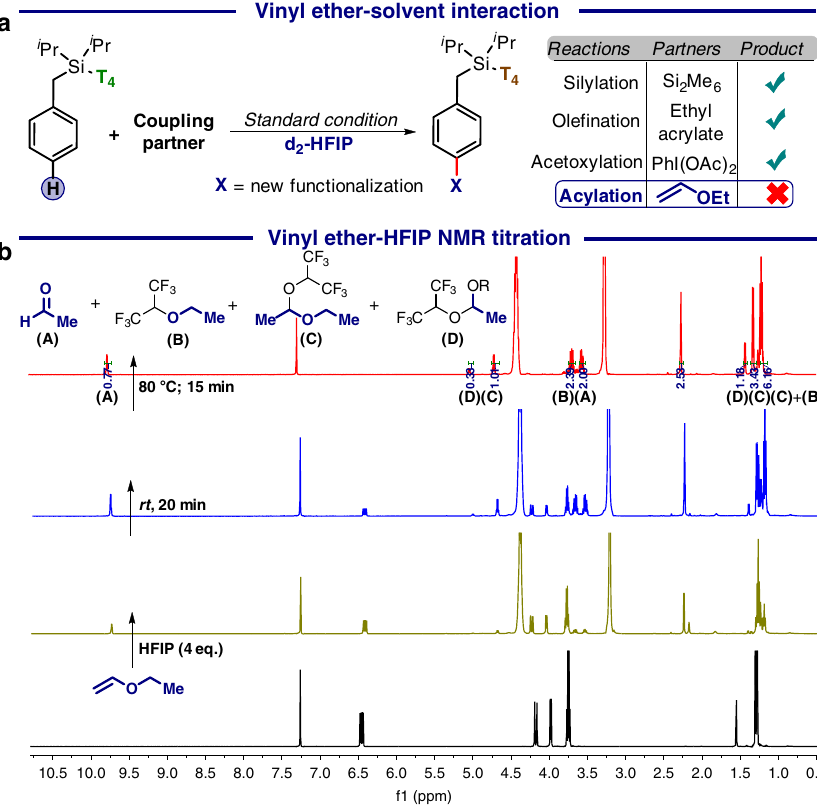
Fig. 3 In fl uence of HFIP. a Control experiment for vinyl ether – HFIP interaction. b NMR study of vinyl ether – HFIP interaction